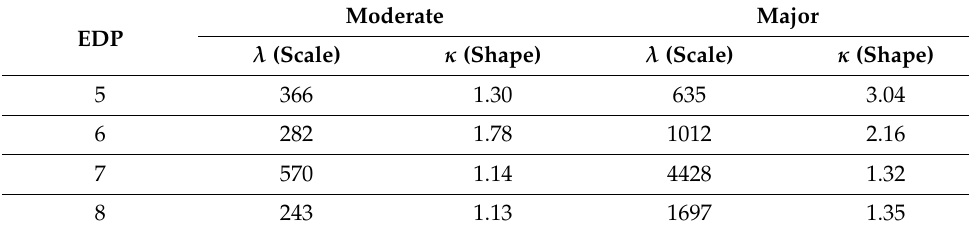
Table 8. Best Estimate Weibull Distribution